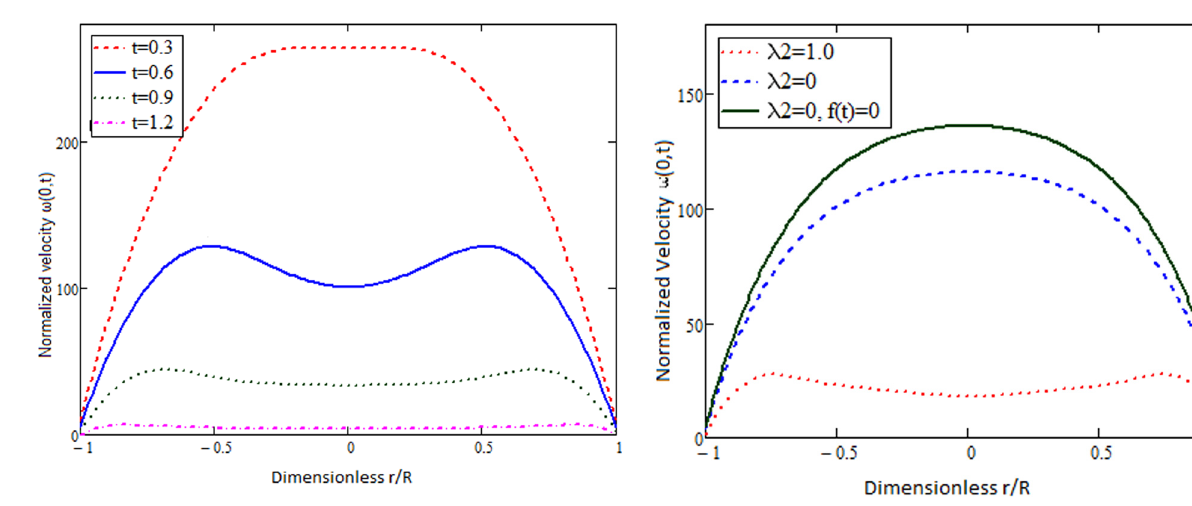
Figure 3: Comparative behavior of Oldroyd - B fl uid ( with ( ) = f t 0 and ( ) ≠ f t 0 ) and Burgers ’ fl uid.